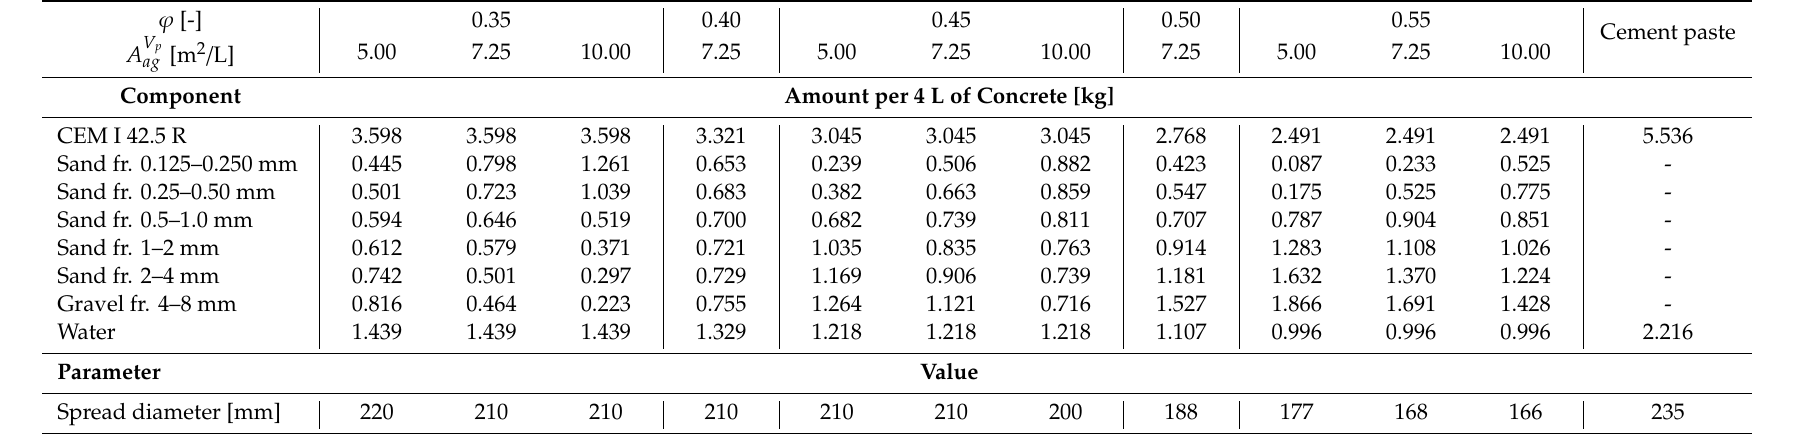
Table 2. Concrete compositions under